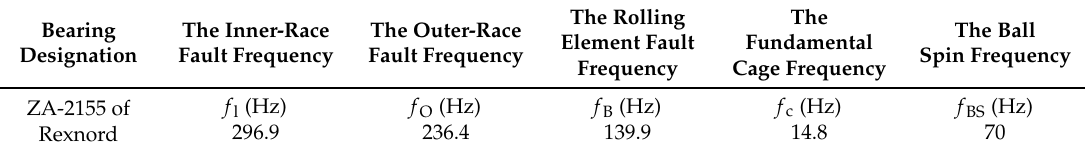
Table 2. Corresponding parameters of the experimental